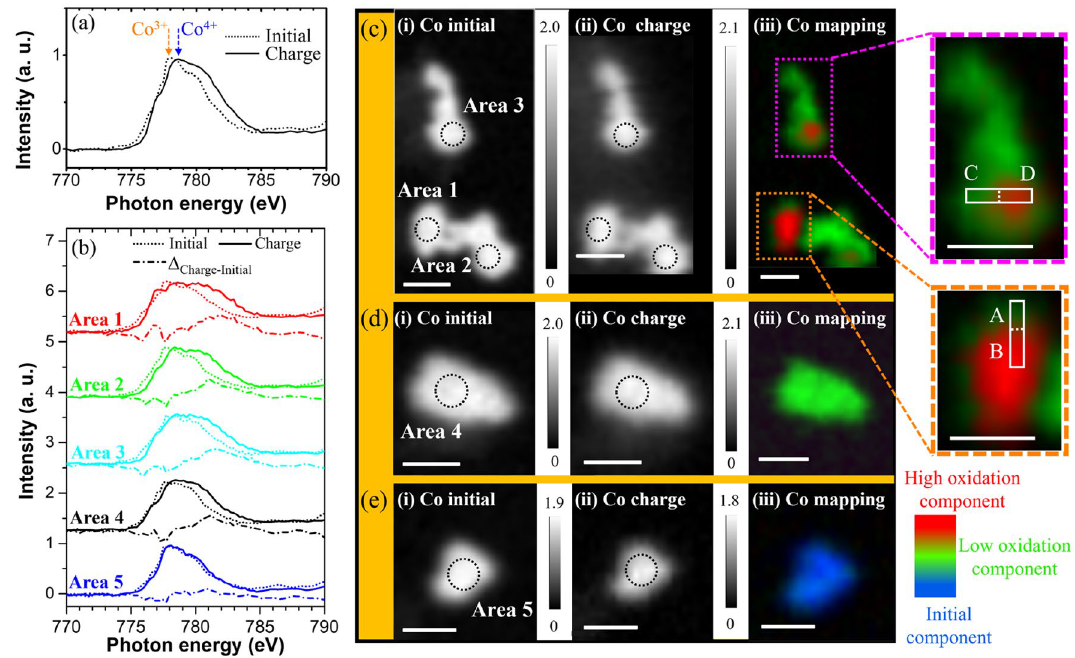
Figure 2. Co L 3 -edge XAS spectra of the initial (dotted line) and charged (solid line) states measured by STXM: ( a ) those averaged over all the particles and ( b ) those recorded at the circled areas (diameter: 300 nm) of the different LiCoO 2 particles in ( c ) , ( d ) and ( e ). Also contained in ( b ) are the difference spectra (dash-dotted lines). ( c–e ) STXM OD images of the Co L 3 -edge of the LiCoO 2 particles obtained at the (i) initial and (ii) charged states, and (iii) stack mappings (770–790 eV) shown by red, green, and blue colors, each indicating the charged states assigned according to the reference spectra (solid lines) obtained from Areas 1 and 2, and the initial state assigned using the reference spectrum (dotted line) obtained from Area 5 shown in ( b ). Enlarged rectangular regions (A, B, C, and D) separated by dashed lines are shown on the right. The red and green colors represent different oxidation states. All the OD images of Co are plotted at 778 eV, and the white scale bars represent 0.5